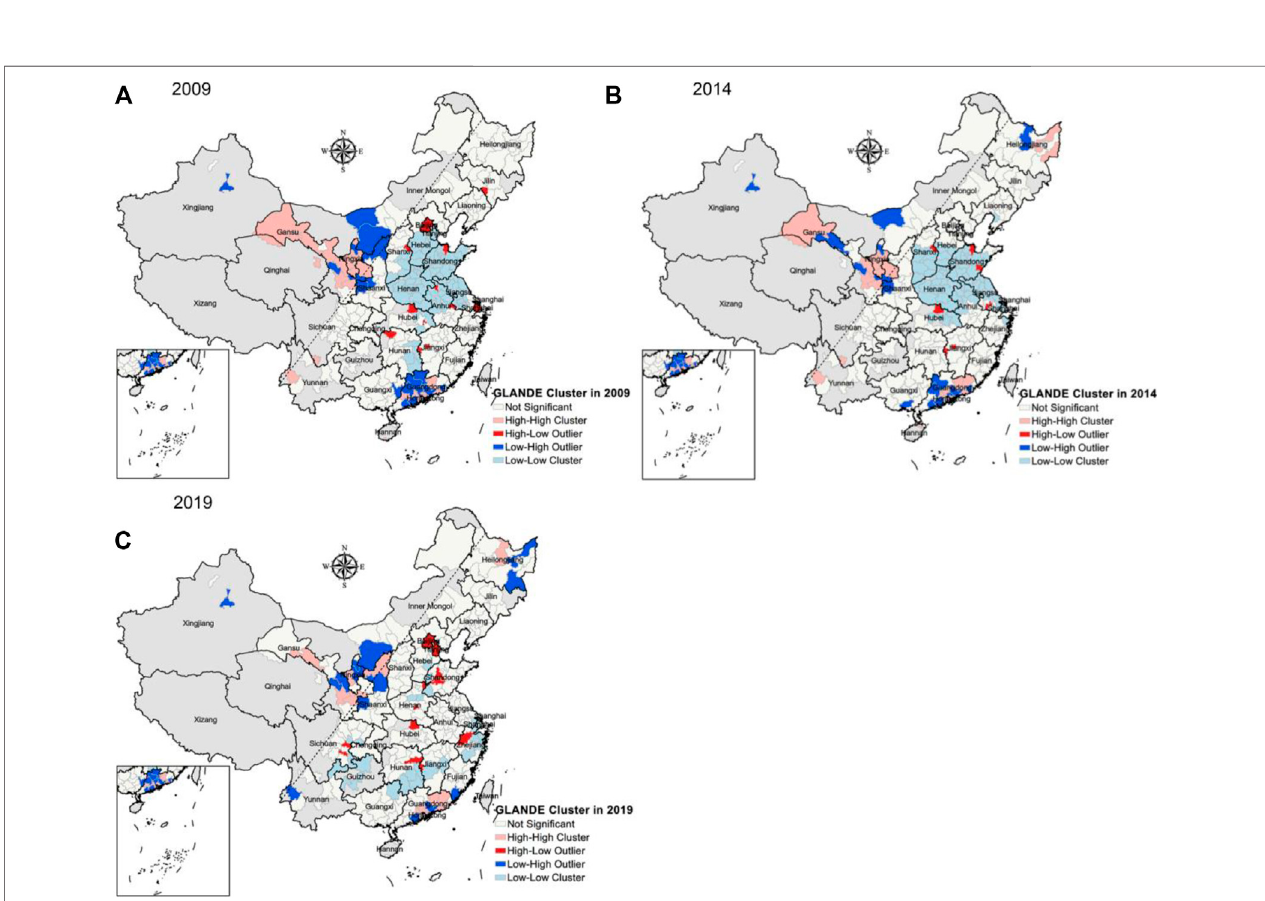
FIGURE5| TheMoranscatterplotofGlande. (A) TheMoranscatterplotofGlandeinChinain2009. (B) TheMoranscatterplotofGlandeinChinain2014. (C) The Moran scatter plot of Glande in China in 2019.